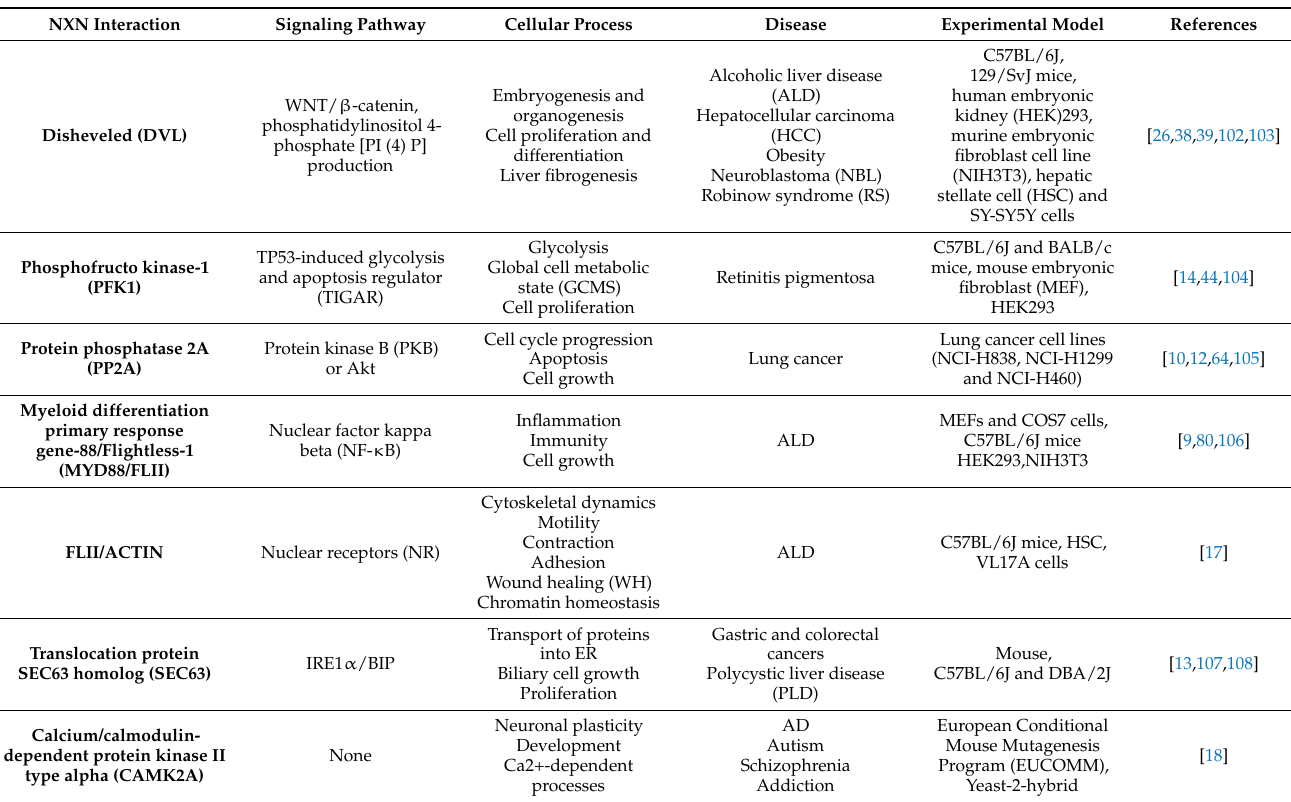
Table 1. Molecular interactions, signaling pathways, cellular processes, and diseases where NXN is involved